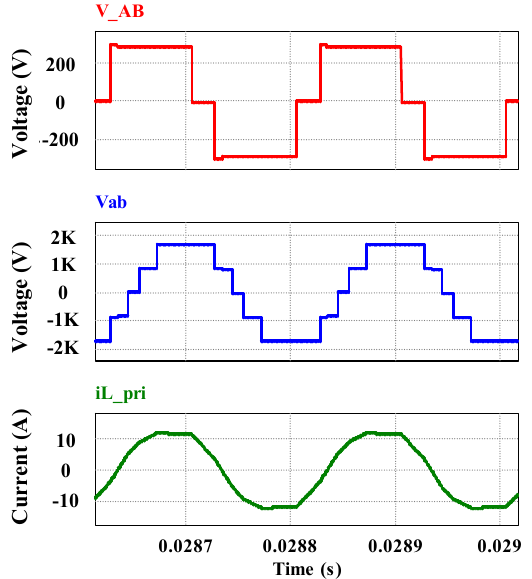
Figure 9. Primary 3L voltage (cid:1874) primary referred leakage inductance (cid:1861) γ = 20 (cid:2868) and (cid:2038) = 60 (cid:2868) .